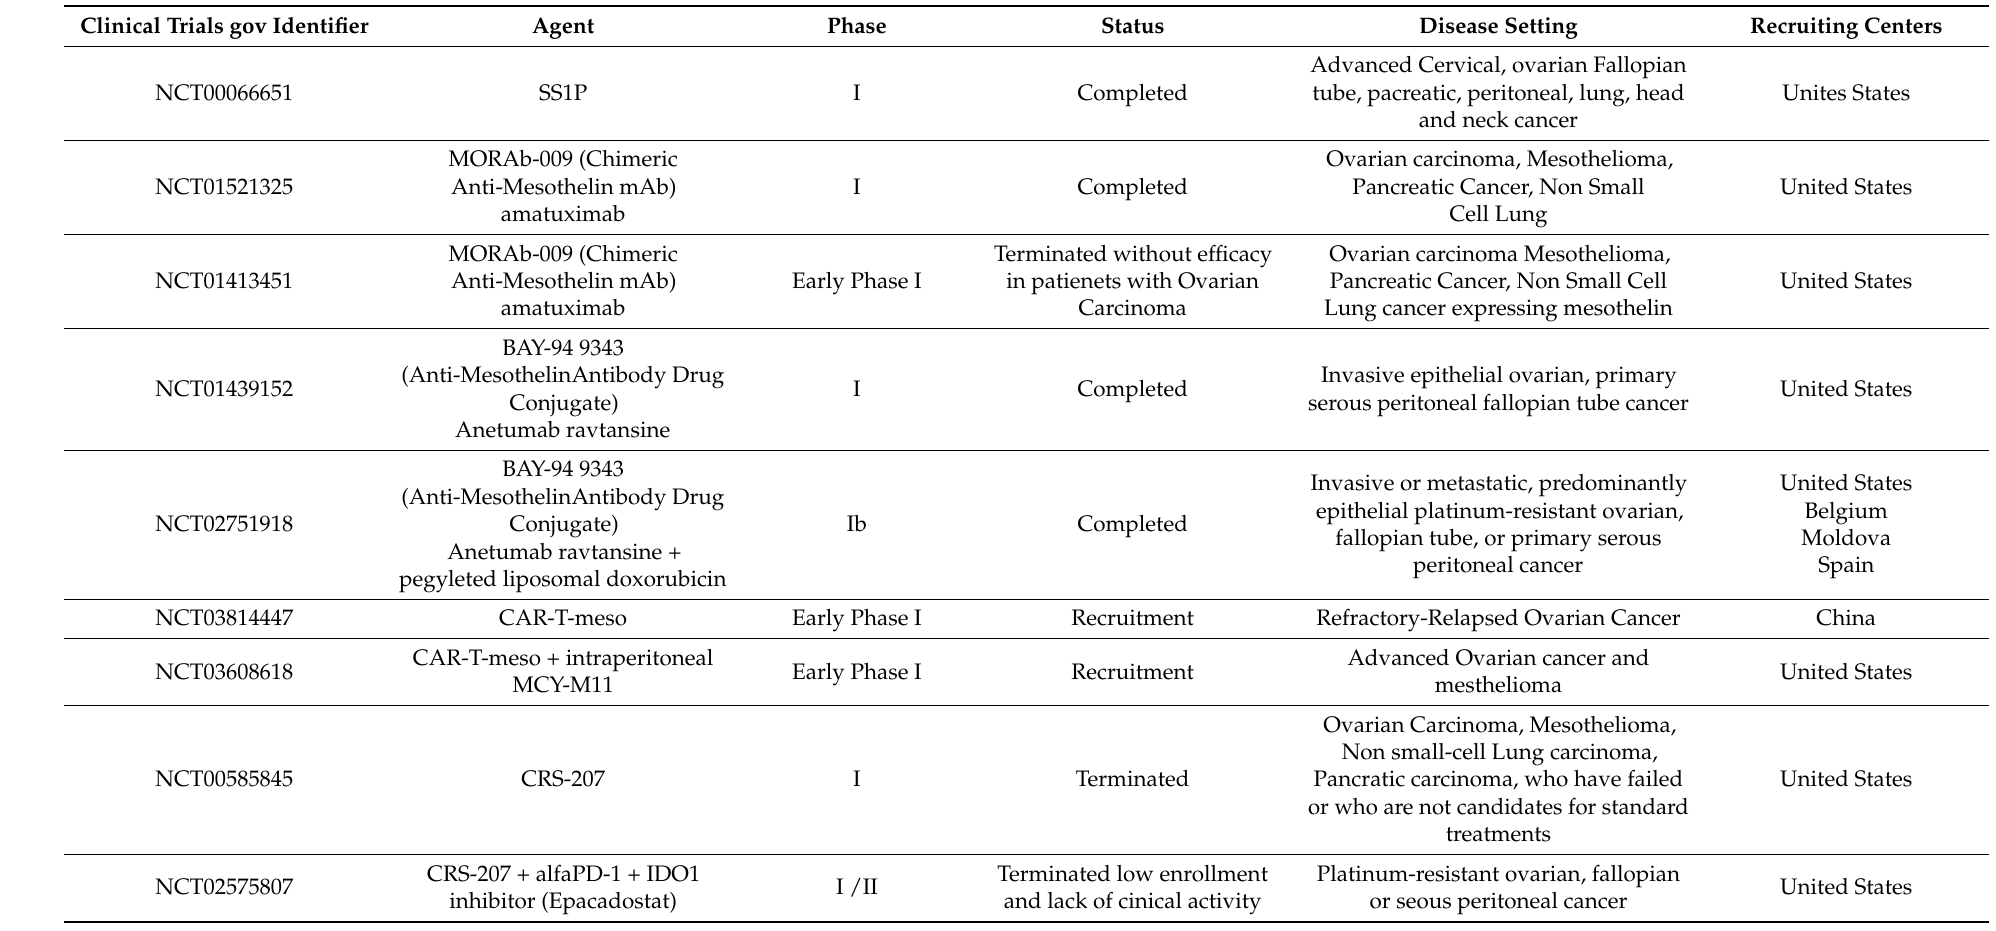
Table 2. Summary of clinical trials using MSLN target therapies for ovarian